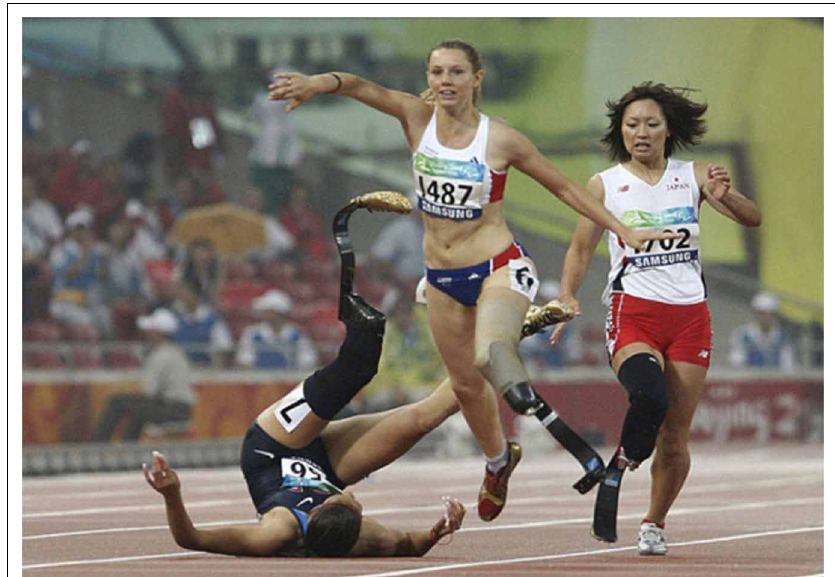
FIGURE 1 | What is this